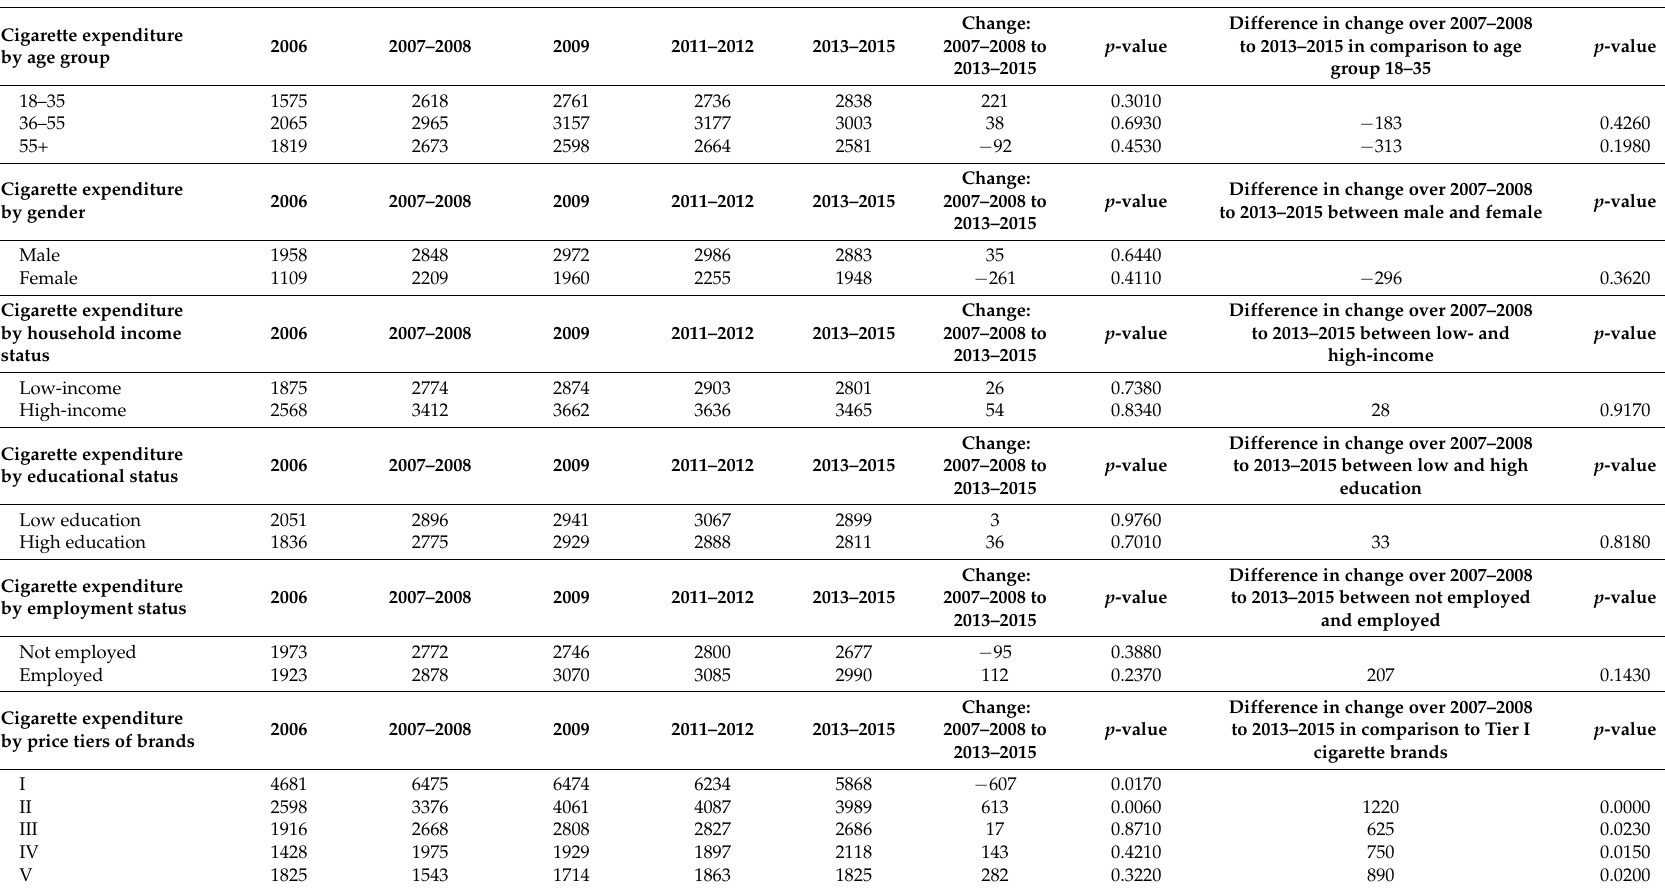
Table 8. Trend in annual cigarette expenditure per smoker in yuan in 2015 constant prices (predicted from GEE estimation) by age, gender, household income status, education, employment status, and price tier of brands in last purchase of smokers in China, 2007–2008 to